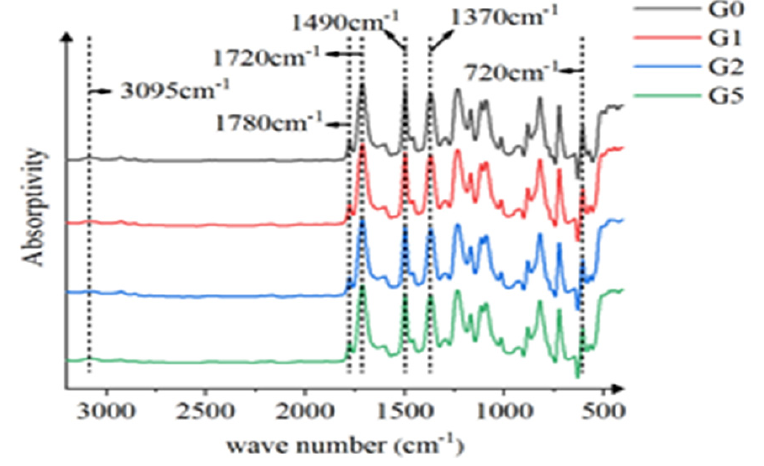
Figure 3. Infrared absorption spectrum.